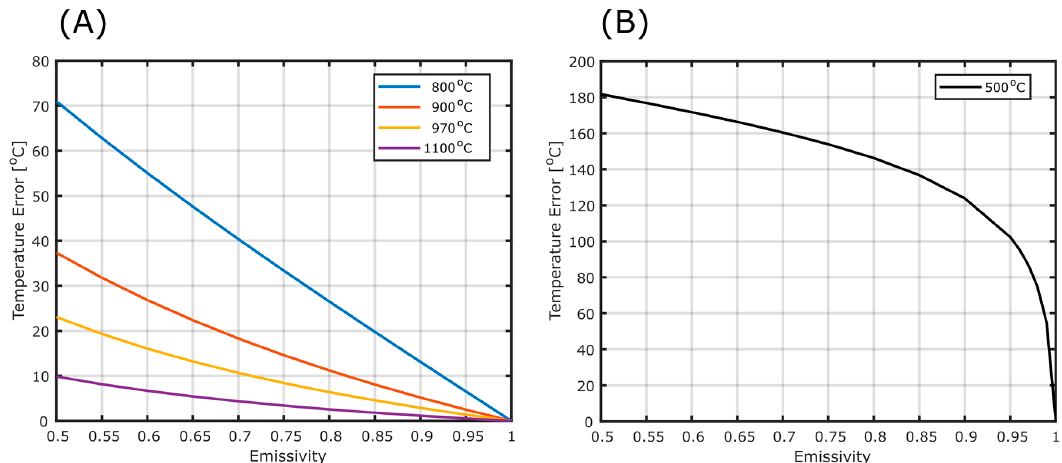
Figure A1. ( A ) Temperature errors associated with solar reflection vs. emissivity, for a range of temperatures. ( B ) As in ( A ) but for a much lower temperature of 500 °C. For lava lake temperatures presented in this article (predominantly 900–1100 °C) errors caused by solar reflections are minimal (all < 6 °C) for emissivities > 0.9. At much lower temperatures (500 °C) the solar effect is much more significant, even at emissivities approaching 1; therefore, it is likely that applications imaging such temperatures would need to be either away from direct sunlight, at night, or possibly with a sophisticated correction for solar radiance.